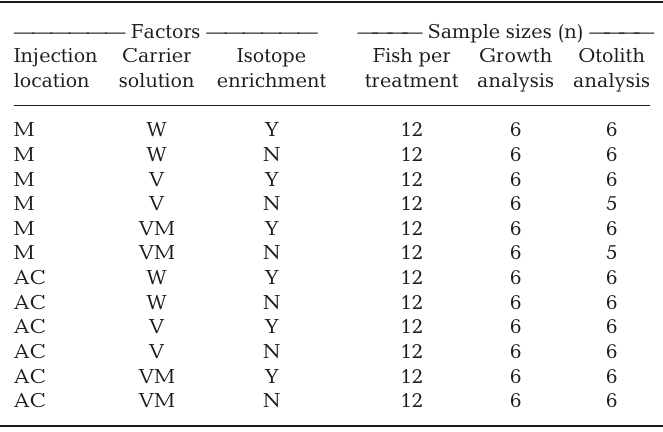
Table 1. Design of the experiment to test mark success and strength through introducing enriched stable isotopes during routine vaccina- tion of Salmo salar via 2 injection sites (muscle [M] or abdominal cavity [AC]), using a vaccine (V), a vaccine mimic (VM), or water